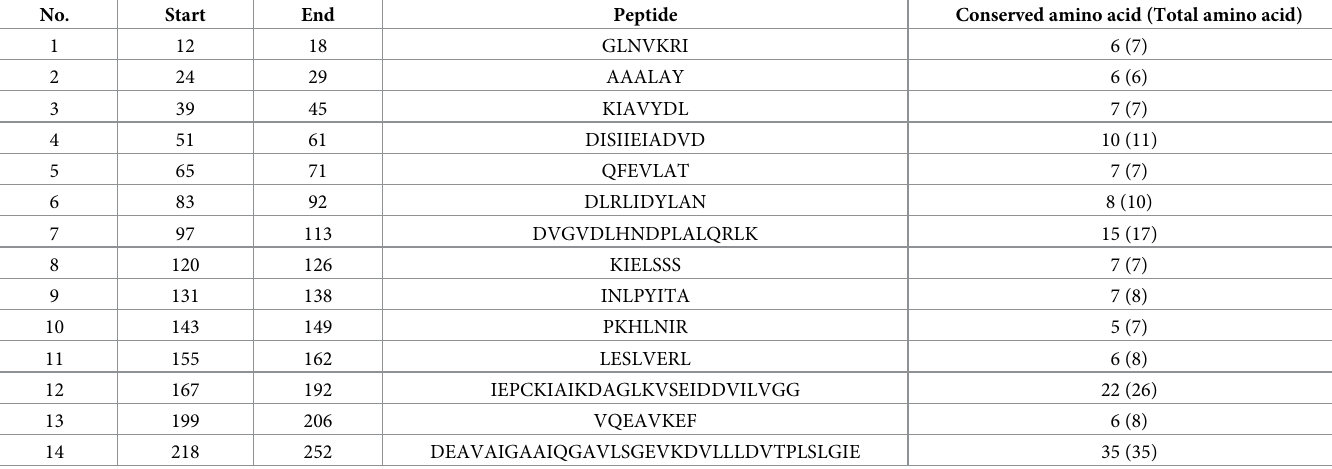
Table 2. Analysis of B-cell epitopes predicted from partial DnaK peptide sequences determined in this study.